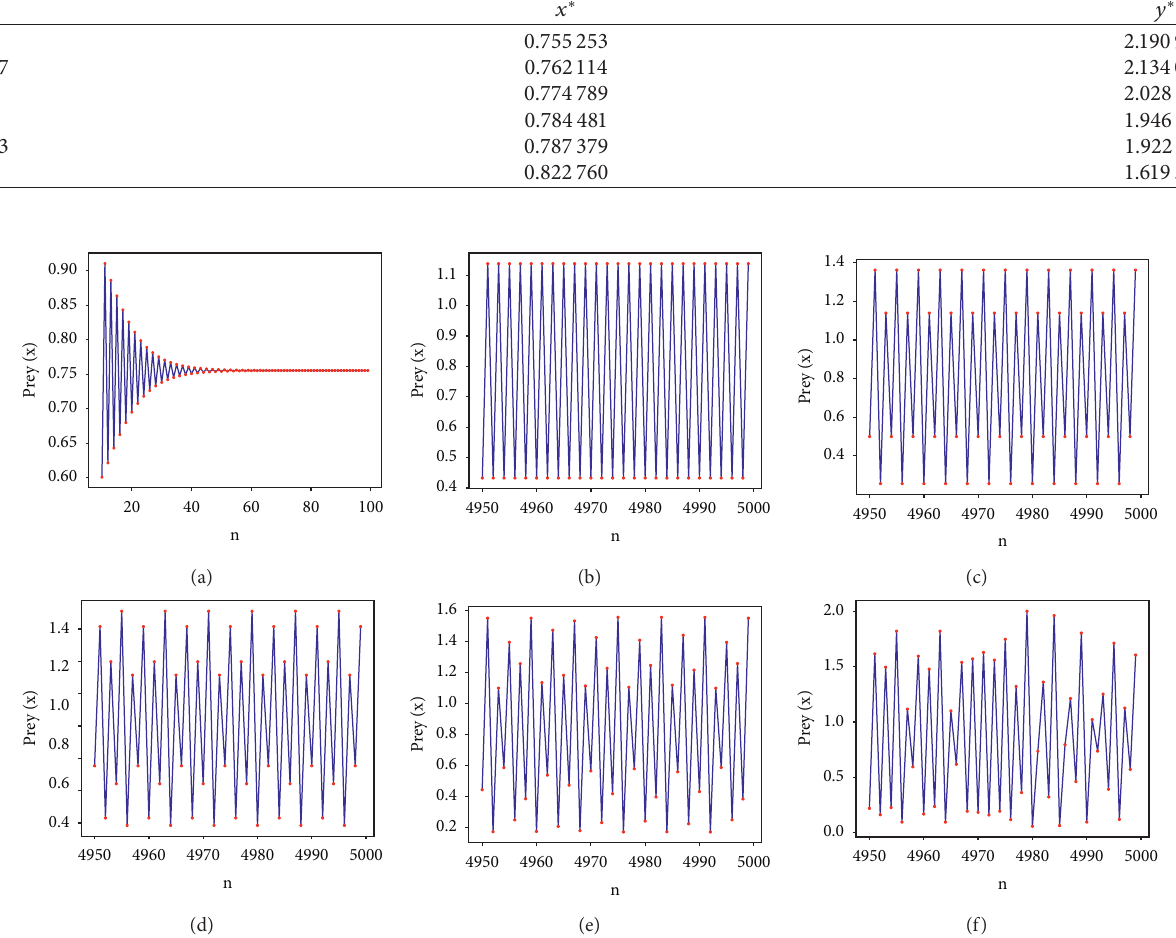
Figure 1: The time series plots for system (5) with r m � 0 . 2, (b) period-2 for m � 0 . 27, (c) period-4 for m � 0 . 4, (d) period-8 for m � 0 . 5, (e) 8-chaotic like attractor for m � 0 . 53, and (f) chaotic attractor for m � 0 . 9.